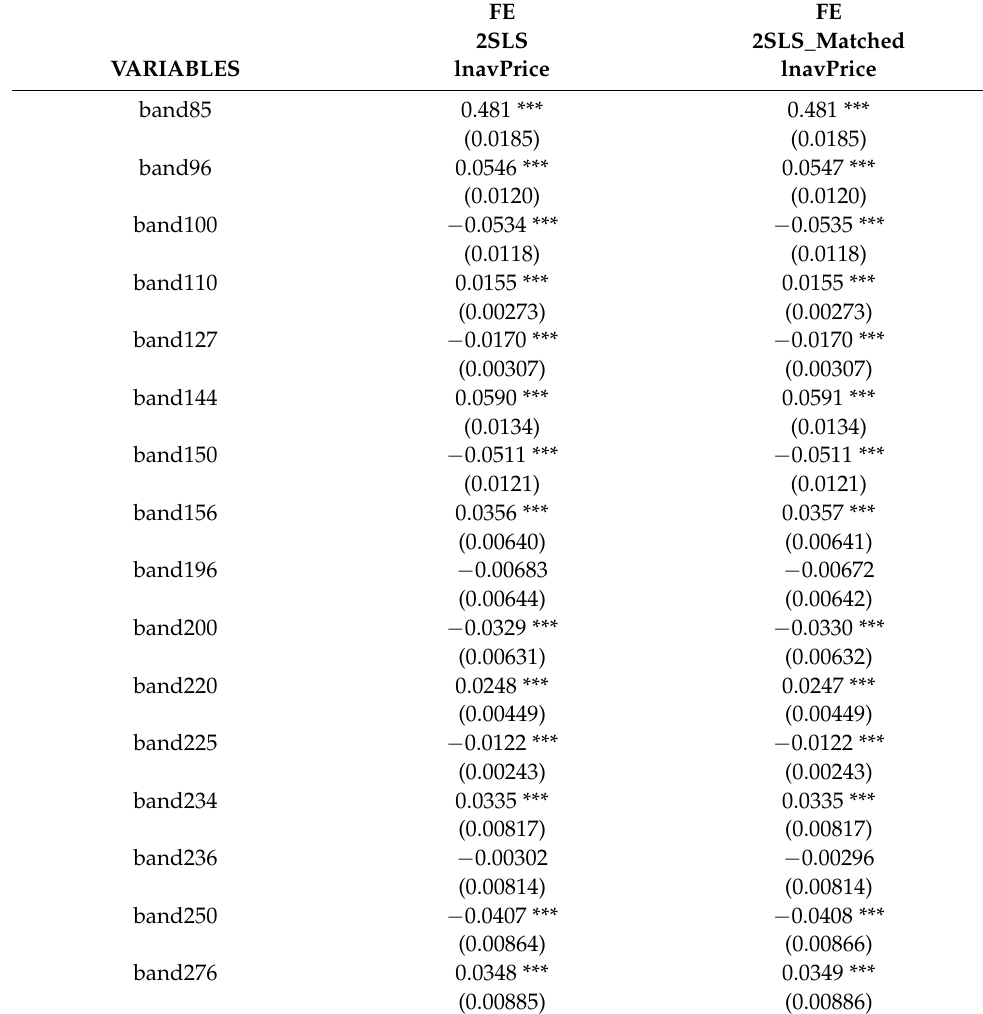
Figure A4. Tariff Schedule for Control Regions (mean) (2010–2019). Source: Federal State Statistics Service.